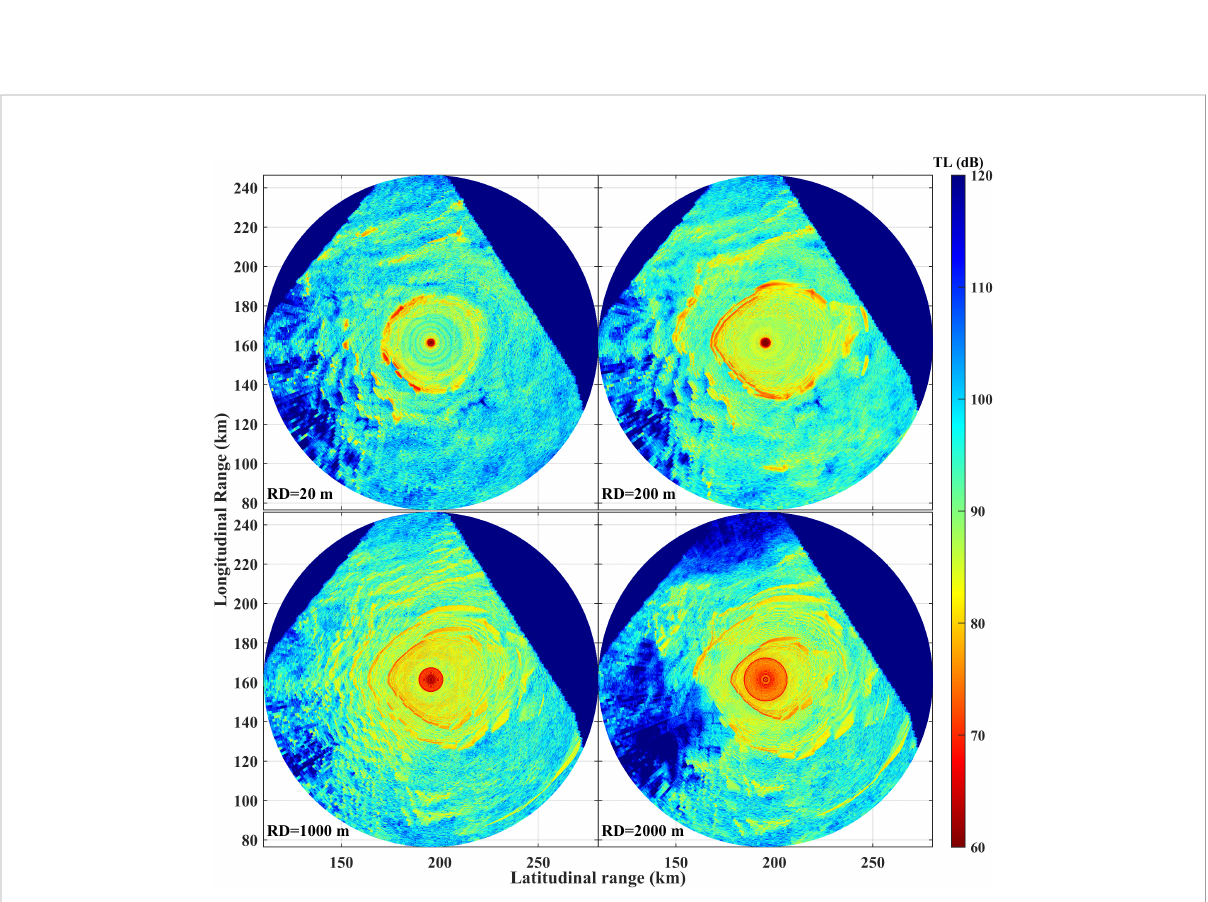
FIGURE 9 The 3D sound fi eld at cartesian coordinate system in the presence of warm eddy and complex topography. The sound source is deployed at 195.5 km, 161.4 km, and 0.185 km with 300 Hz frequency. Top views of the TLs at receiver depths of 20 m, 200 m, 1000 m and 2000 m are shown, respectively.